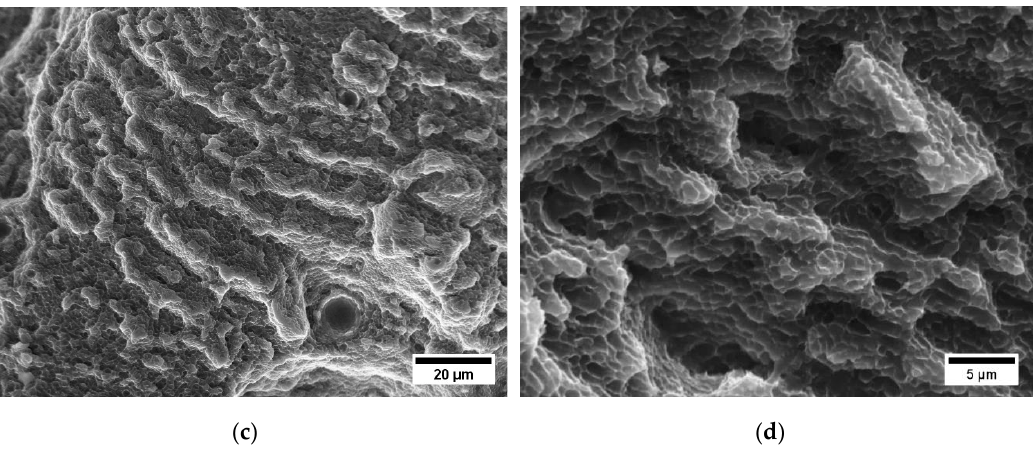
Figure 16. Fracture surface of a SB specimen failed at maximum stress level of 155 MPa. ( a ) Interface between region II and III of crack propagation; ( b ) high magnification view of small pores interacting with crack growth front in region II; ( c ) deeper ridges and ( d ) micro-dimples detected in region III.